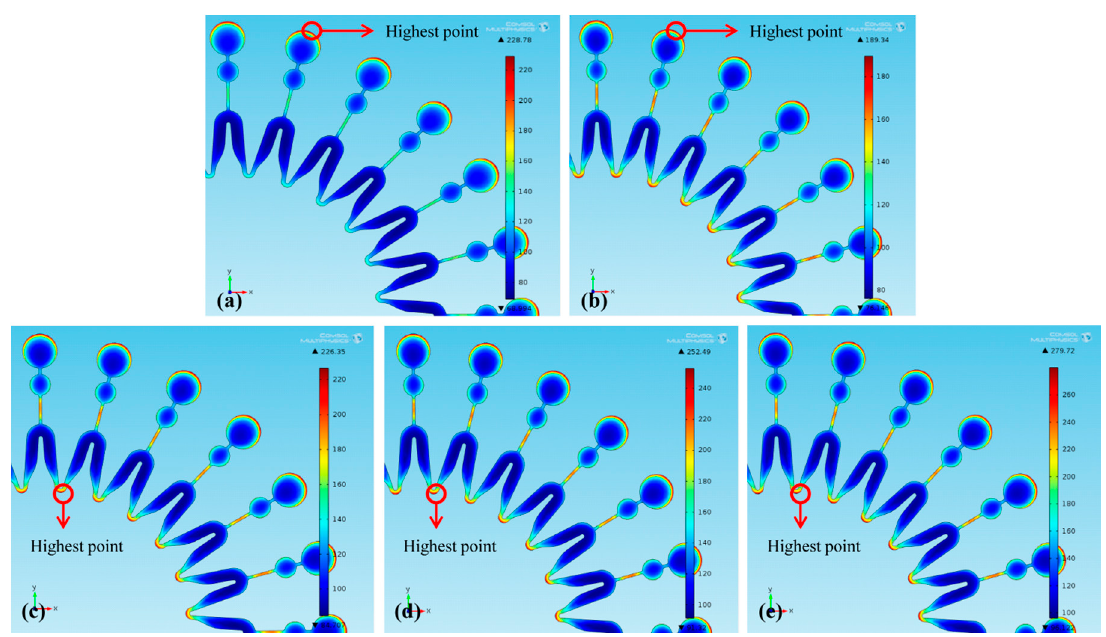
Figure 7. Current density distribution on the mold surface: ( a ) without a second cathode; ( b ) W = 4 mm; ( c ) W = 5 mm; ( d ) W = 6 mm; ( e ) W = 7 mm.